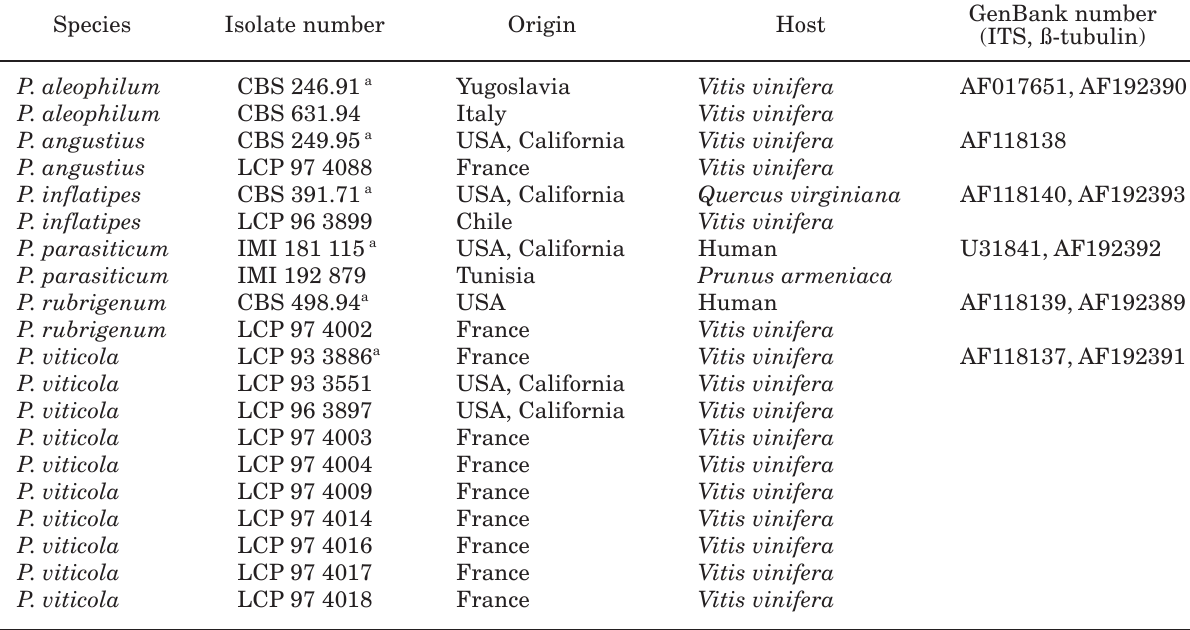
Table 1. Isolates of Phaeoacremonium used in this study.